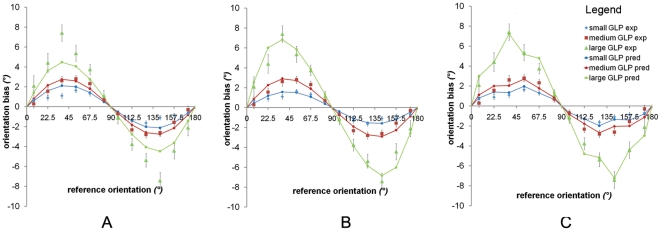
Model predictions.The three trend lines (see legend) are the average predictions per GLP thickness for the six participants for A) homogeneous anisotropic smoothing, B) radial heterogeneous anisotropic smoothing (av, ah depending on GLP thickness) and C) angular heterogeneous anisotropic smoothing (av, ah, r depending on GLP orientation). The markers are the average experimental results adopted from Figure 4B.